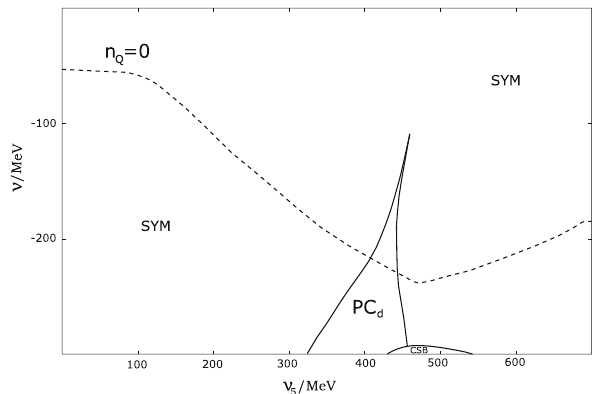
Fig. 6 The (ν 5 ,ν) -phase diagram of β -equilibrium quark matter (see the model (7), (8)) at μ = 500 MeV and μ 5 = 0 in the chiral limit, m 0 = 0. All the notations are the same as in Figs. 1, 2 and